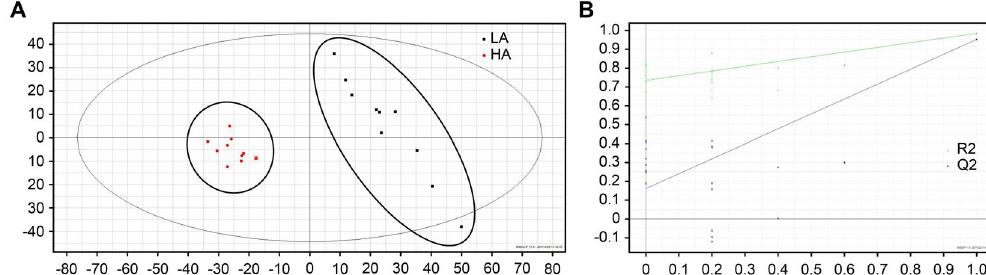
Figure 1. Score plots obtained from the non-targeted Q-TOF/MS analysis. ( A ) Qualitative profiling of the LA and the HA was conducted through PCA. Their metabolic patterns showed apparent separation. ( B ) Score plots of PLS-DA in the UPLC and positive ESI ion mode. Their metabolic patterns were fully discriminated from one another (R2Y = 0.98; Q2 = 0.95). The X-axis and Y-axis represent the two highest X-scores of dimensions 1 and 2 for matrix X of the mass ion abundances, respectively (black squares: LA; red circles: